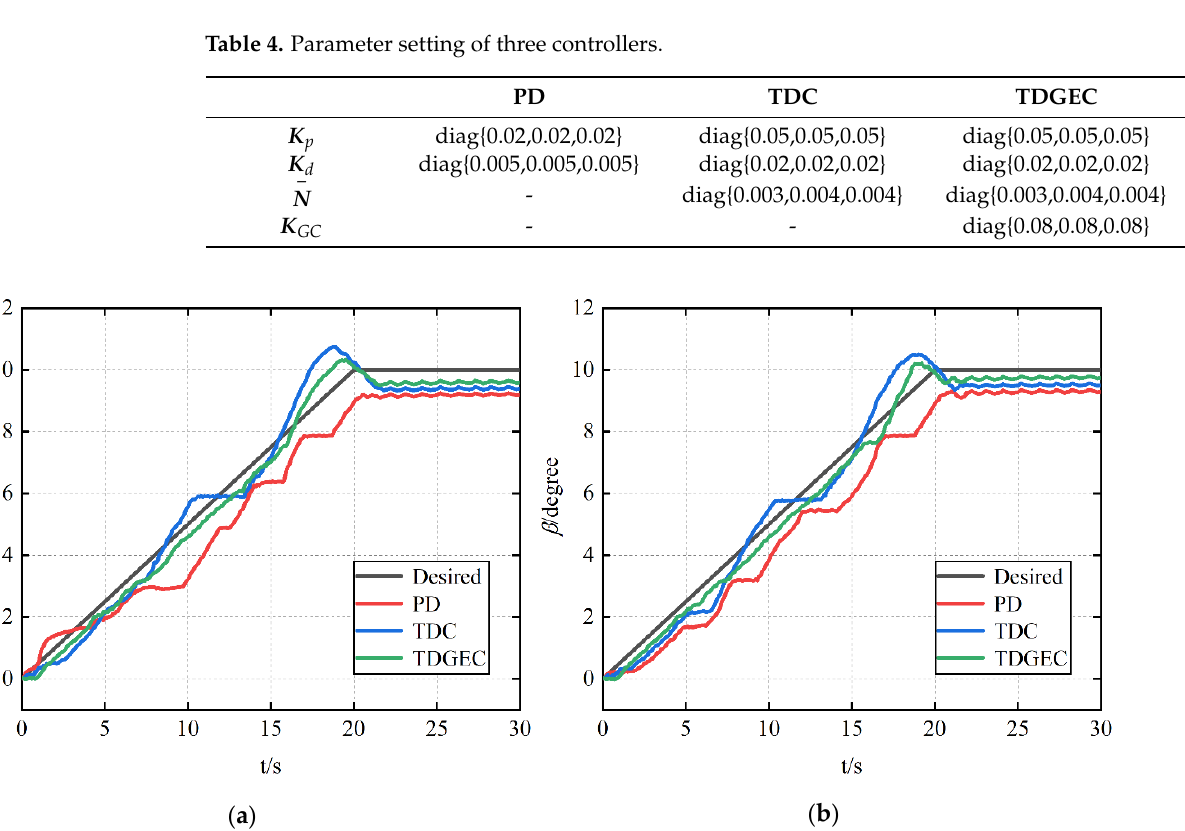
Figure 12. Trajectory tracking curves: ( a ) α -axis tracking trajectory and ( b ) β -axis tracking trajectory.